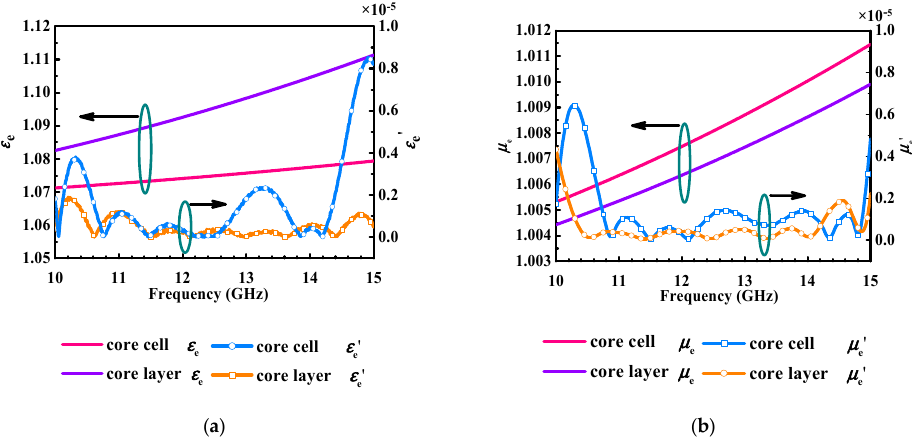
Figure 6. The EM parameters of periodic cell and layer in real and imaginary parts, ( a ) effective permittivity ( b ) effective permeability.